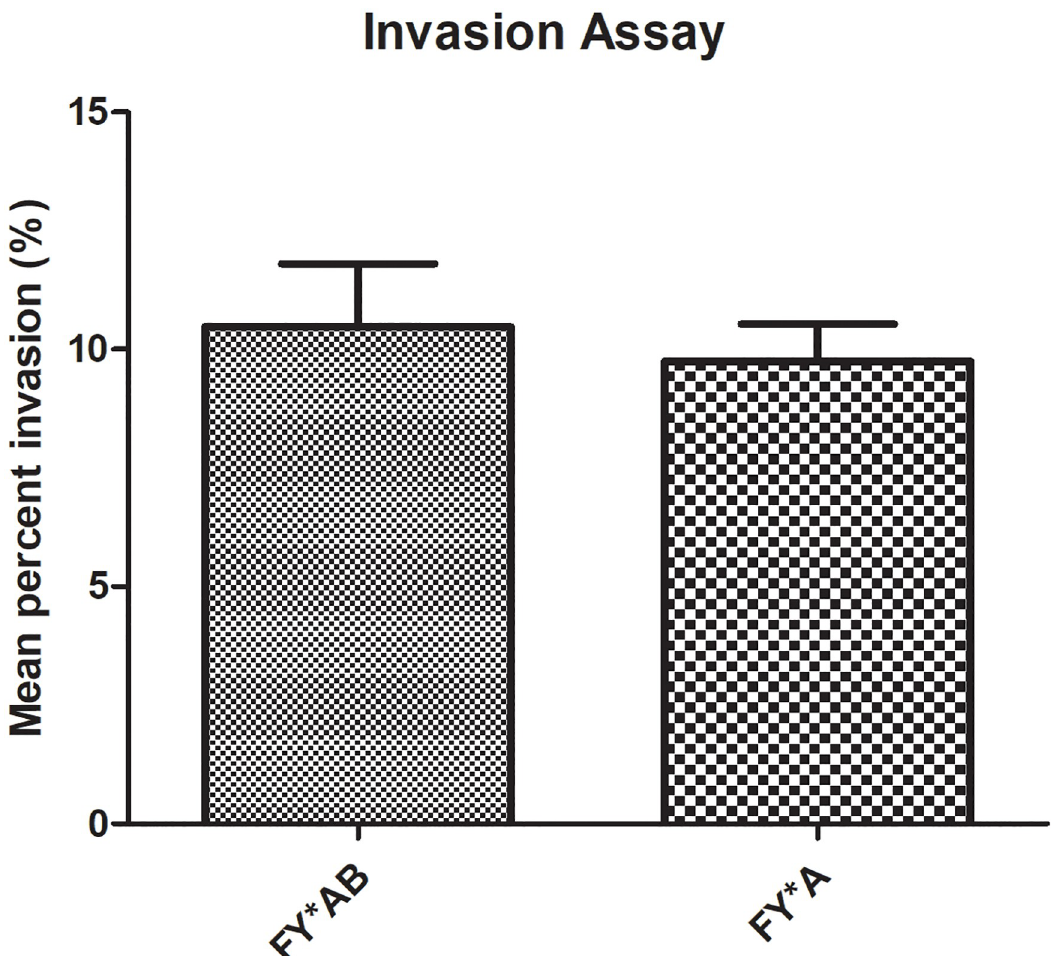
Fig 1. Mean percent invasion of P . knowlesi in FY � AB/ FY � A and FY � A/ FY � A Duffy blood groups. Data shown was the mean percent invasion with standard deviation in each group. The difference between FY � A/FY � A or FY � A/FY � B genotypes was not significantly different. � P <